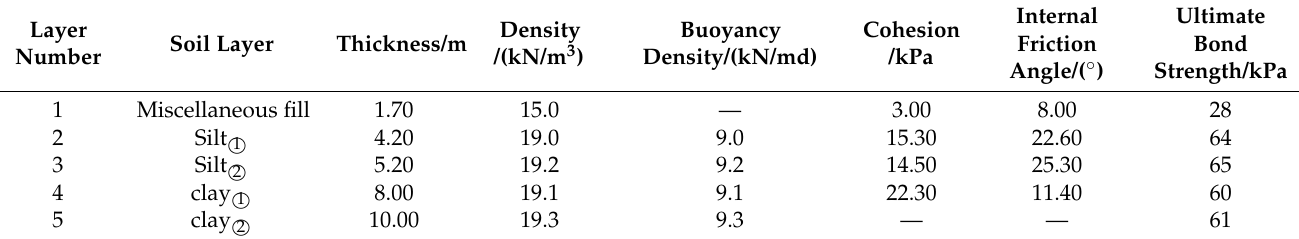
Table 3. Physical and mechanical parameters of soil layers.